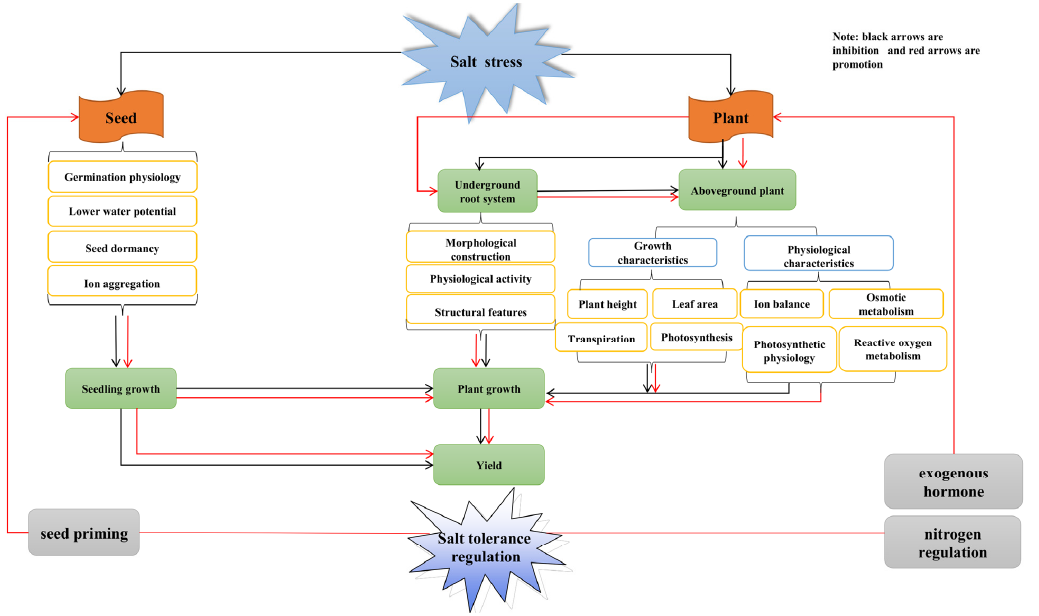
Figure 1. Effect of salt stress on sorghum growth physiology and salt tolerance regulation network fi gure. 3. E ff ects of Gibberellins on Germination and Emergence of Sorghum under Salt Stress Gibberellins (GAs) are plant endogenous growth regulators that promote cell divi- sion and germination and break bud dormancy in plants under abiotic stress [20]. Exoge- nous GA amendment at appropriate levels can promote the germination and emergence of sorghum under salt stress. An et al. found that 144 µM and 288 µM gibberellic acid successfully promoted water uptake and the germination of sorghum seeds [21]. The mechanism behind this is that GA 3 , at suitable levels, can promote the water uptake of sorghum seeds, increase the synthesis and activities of a variety of enzymes associated with germination, and a GAs, however, inhibit sorghum germination, emergence, and seedling growth [24]. In a previous study, 576 µM GA 3 inhibited the water uptake of sor- ghum seeds and consequently reduced germination, emergence, and early seedling growth [9]. High concentrations of gibberellic acids can also cause osmotic stress, interfere with the normal metabolism of proteins and nucleic acids, inhibit cell di ff erentiation and development, and thereby slow down plant growth [25]. It has been demonstrated that GA 3 is synthesized at the root tip or leaf tip, and root growth depends on GA 3 regulation of cells in the apical root meristem and elongation zone, while excessive salt induces an increase in ABA, which inhibits root apical growth hormone and GA 3 synthesis and causes accumulation of DELLA protein in elongation zone cells and inhibits root growth and development by limiting cell proliferation and elongation [26,27]. GA 3 at suitable levels can alleviate the stress of salt on the root system of sorghum plants. On the one hand, foreign amendment of GAs can alleviate cell wall thickening and elevate the cellulose and hemicellulose content of root cells caused by salt stress, allowing the rapid entry of water into root cells. On the other hand, the amendment of exogenous GAs can also change the dynamic balance of endogenous hormones in cells and combine with various receptors to induce the expression of related ions and enzymes. GA participates in the antioxidant system, promotes root development and alleviates